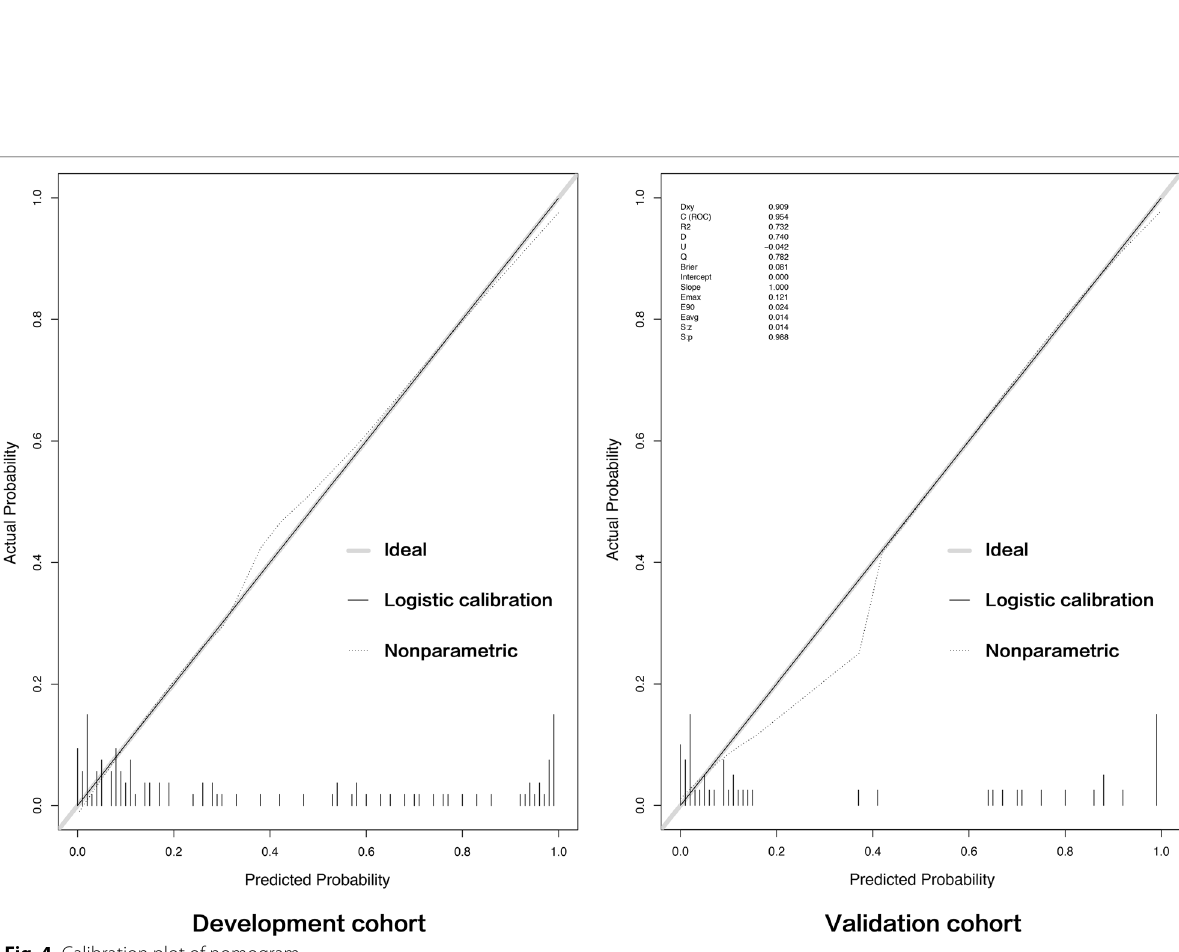
Fig. 4 Calibration plot of